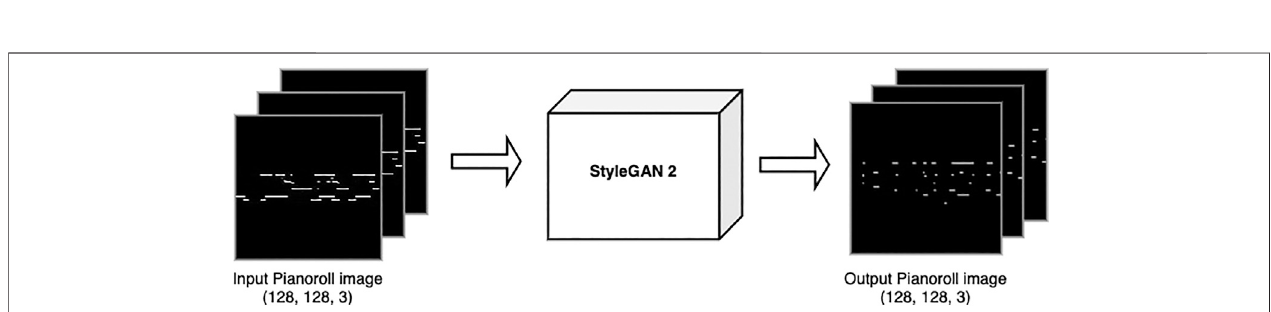
FIGURE 7 | Representation of input and output of the StyleGAN 2 network with piano rolls. A symbolic representation of a musical excerpt in the form of a 128 × 128 × 3 piano roll is used to train the network. The output is another piano roll, which can later be transformed into midi or audio.